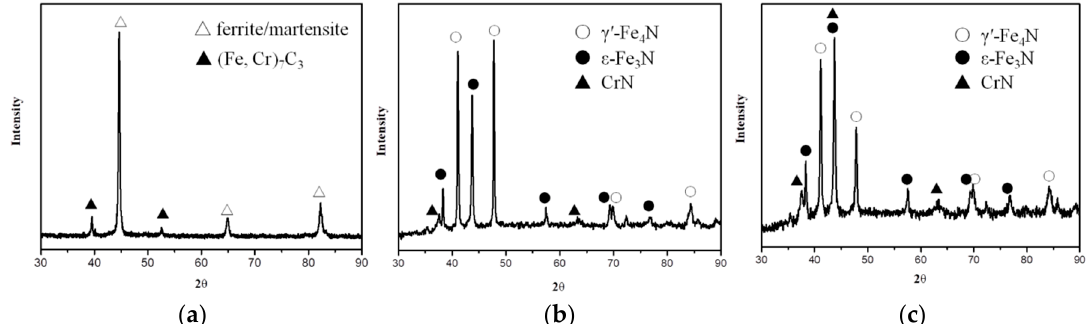
Figure 4. X-ray di ff raction from the surface of ( a ) un-nitrided specimen, ( b ) nitrided specimen before polishing and ( c ) nitrided specimen after polishing.